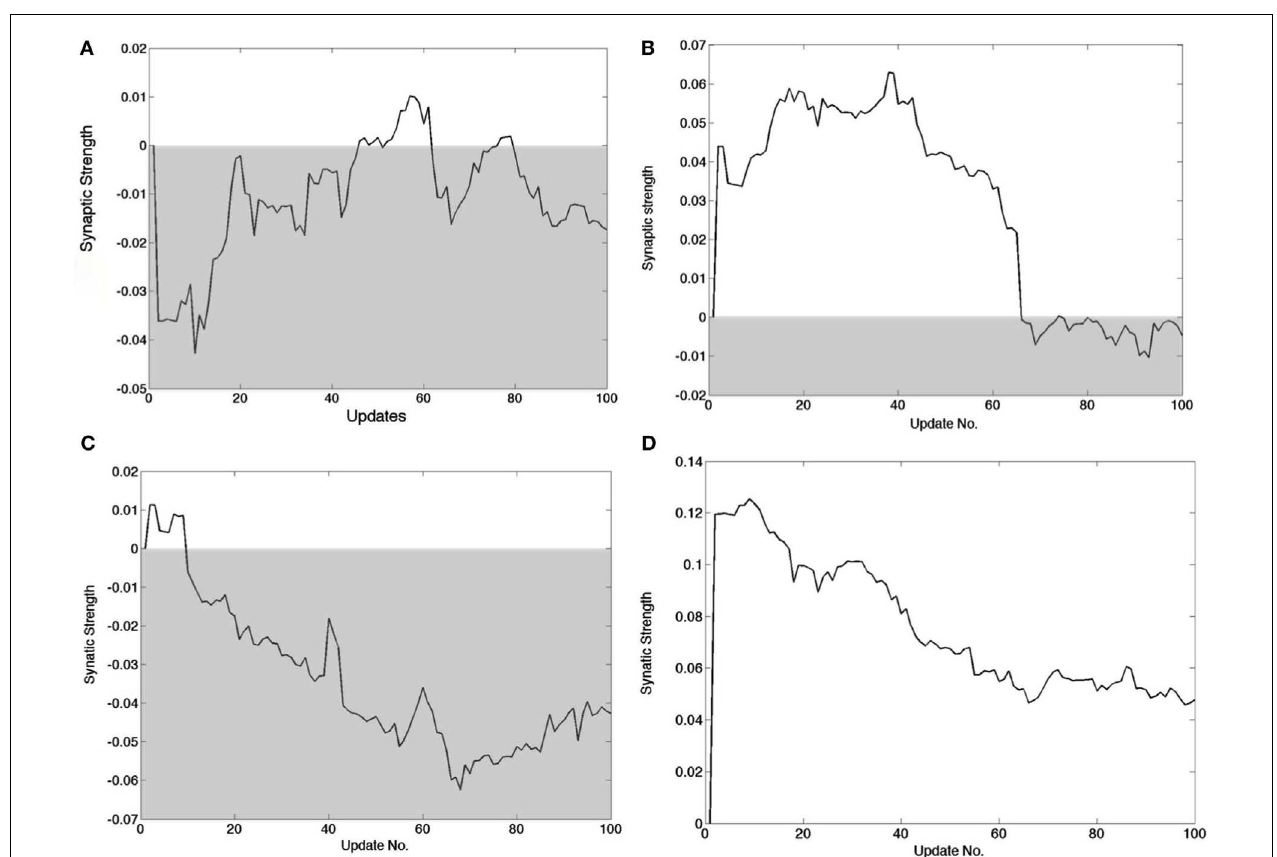
that if briefly positive in two instances but ends up negative. (B) A synapse that is positive for most of the learning process but ends up slightly negative. (C) A synapse that starts out positive but very soon becomes negative and remains so. (D) A synapse that decreases in strength but is always